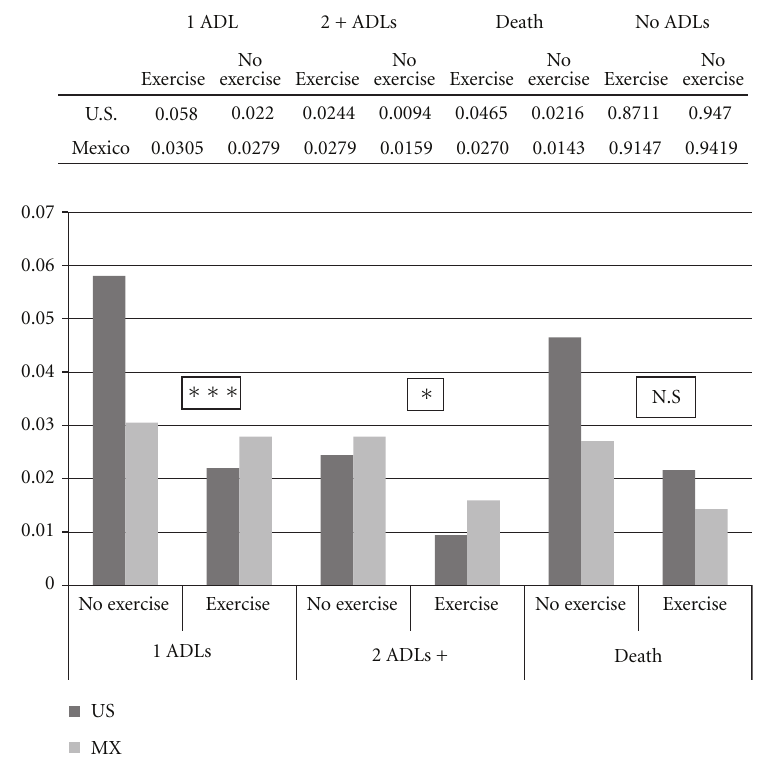
Figure 1: Probabilities of outcome at time 2, by country and exercise at time 1, for persons without ADL limitations at time 1. Notes: ∗ P value < .05, ∗∗ P value < .01, ∗∗∗ P value < .001; across country significance, N.S: not statistically significant across